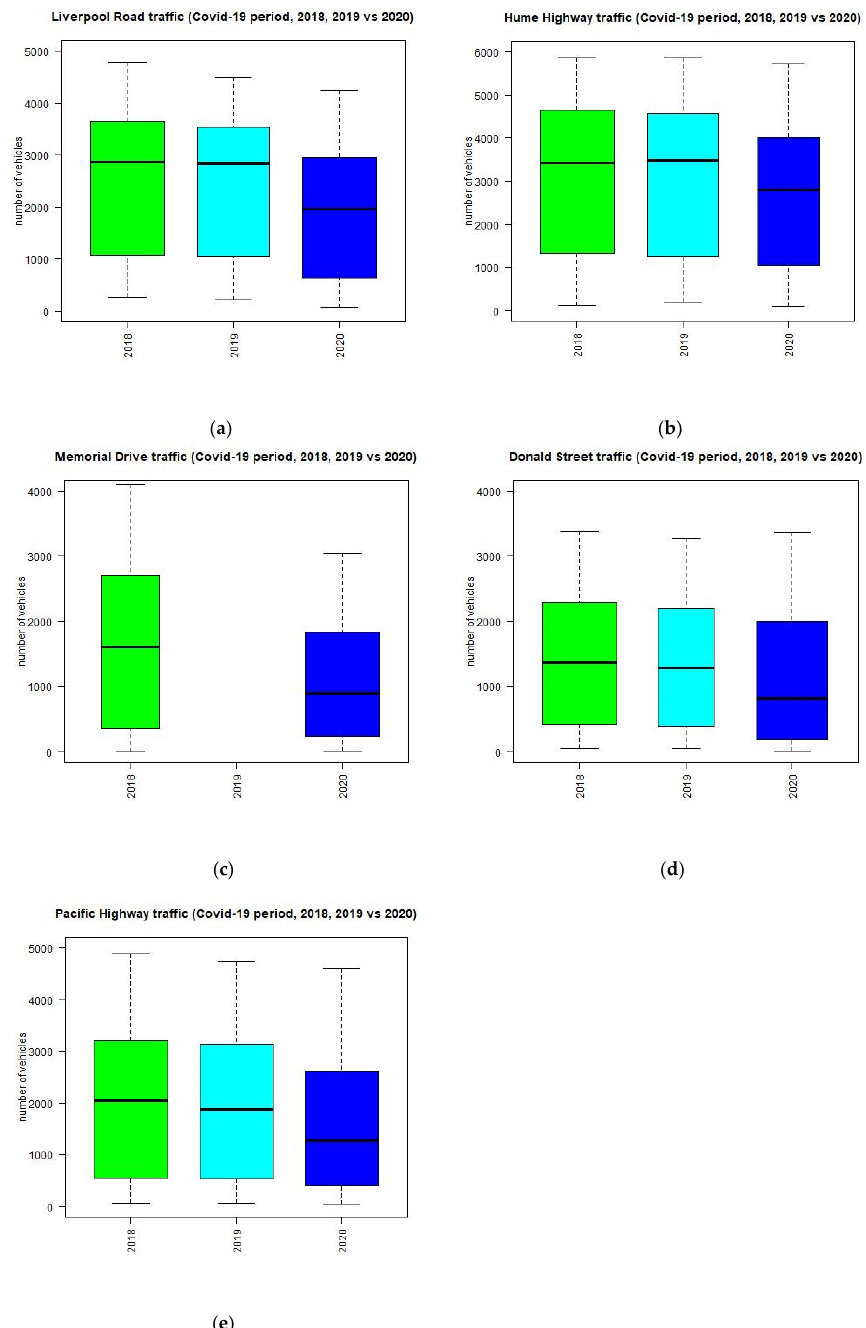
Figure 3. Boxplot of traffic volume per hour in 2018, 2019, and 2020 during the period of April to June at Liverpool Road ( a ), Hume Highway ( b ) in Sydney, Memorial Drive in Wollongong ( c ) and Donald Street ( d ), Pacific Highway ( e ) in Newcastle. Table 2. Traffic counting site and comparison of 2019 and 2020 median hourly traffic volume.